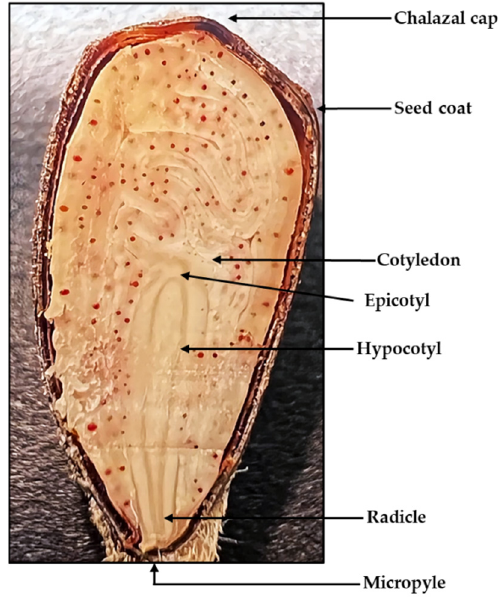
Figure 1. Anatomy of a cotton seed embryo.